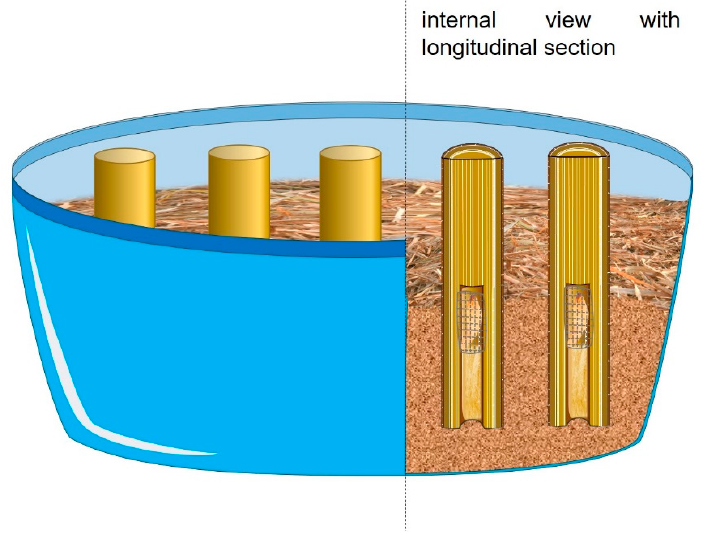
Figure 2. Basin containing 5 rhizomes with Galleria mellonella larvae held inside, partially buried in the soil.